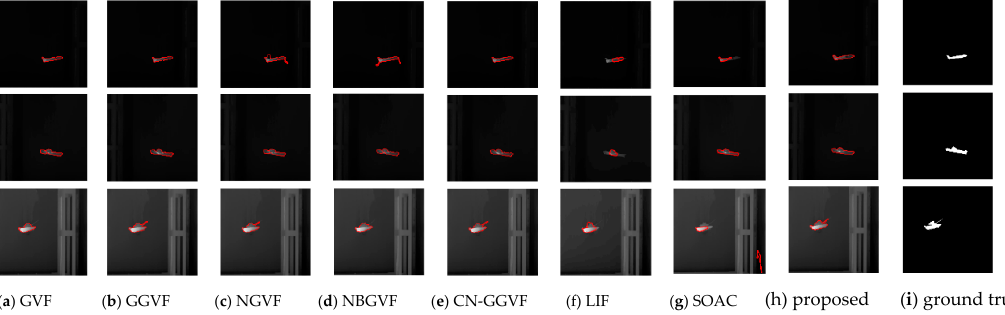
Figure 9. Segmentation results of usual infrared images.